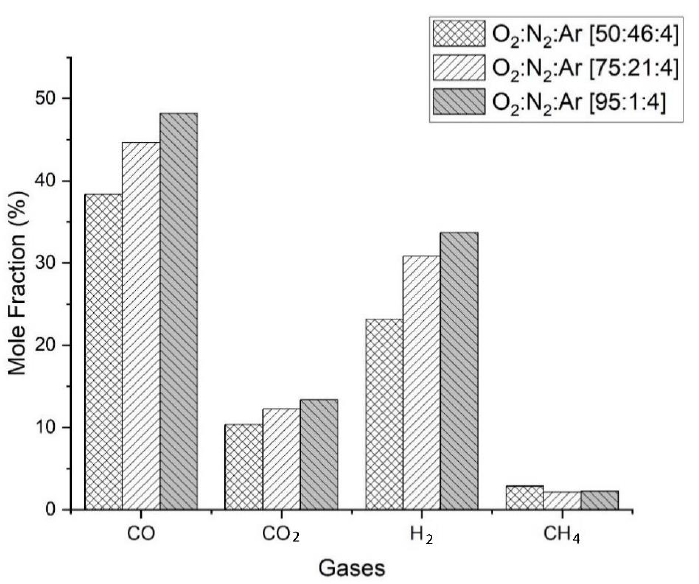
Figure 10. Mole fractions (% dry basis) for product gas yields for different oxidizer compositions.